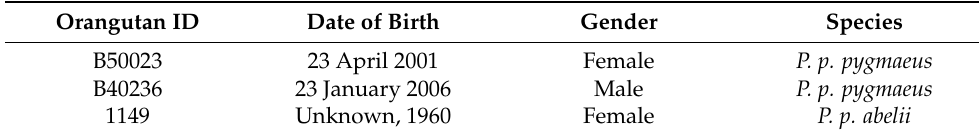
Table 1. Orangutan identification and demographic